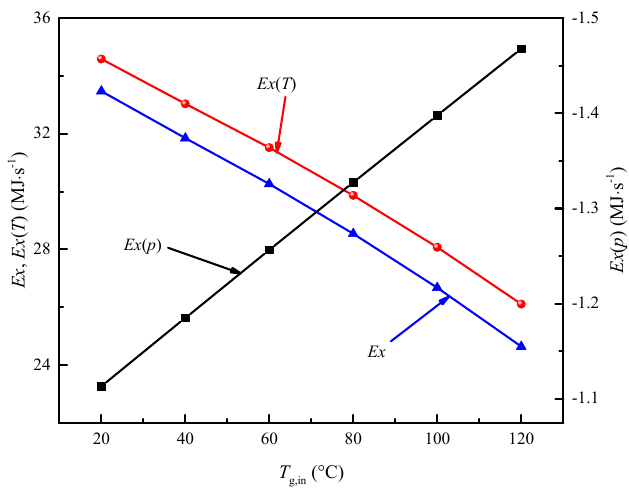
Figure 8. E ff ects of the air inlet temperature on enthalpy exergy Ex , temperature exergy Ex ( T ), and pressure exergy Ex ( p ).